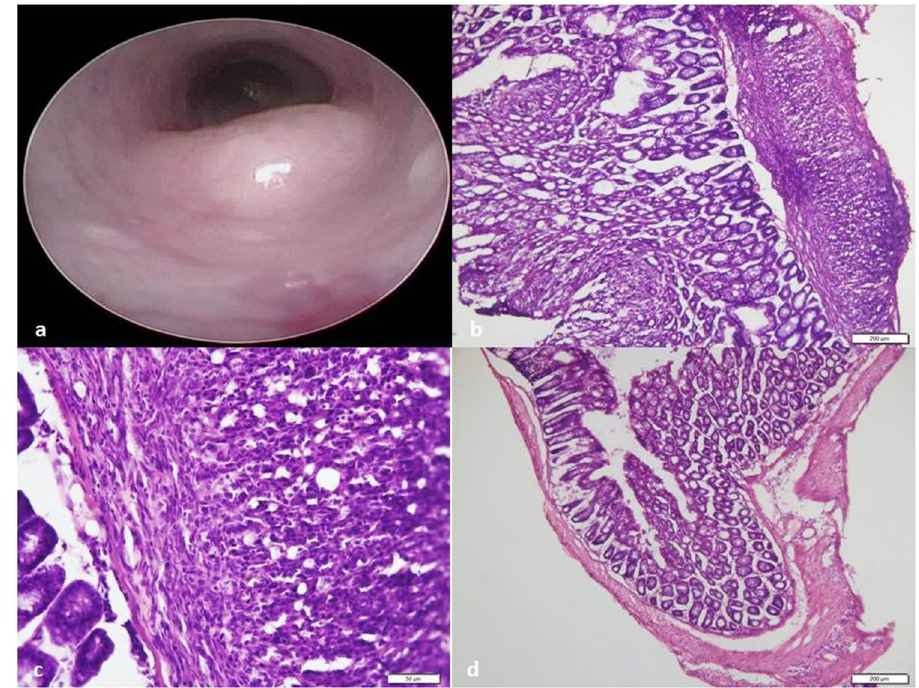
Figure 1. Endoscopic and histologic appearance of the rectal tumor model used in imaging experiments. ( a ) Endoscopy performed 2 days before fluorophore inoculation, showing the tumor protruding at the rectal lumen. ( b ) Histologic section showing an intact mucosa (left) and the tumor cells in the serosa (right) (x100). ( c ) Higher magnification of B (x400). ( d ) Distal normal colon shown for comparison